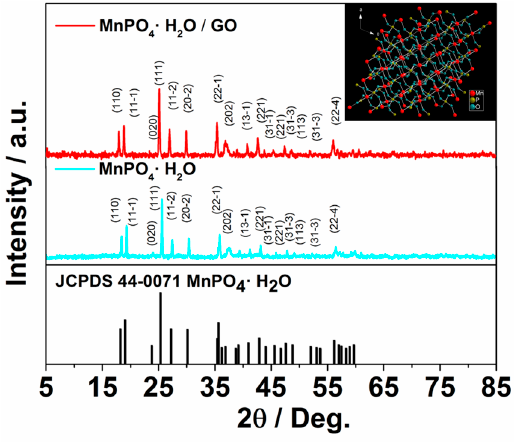
Figure 1. XRD (X ‐ Ray Diffraction) patterns of as ‐ prepared MnPO 4 ∙ H 2 O nanowire/GO (graphene oxide) composite material, as ‐ prepared MnPO 4 ∙ H 2 O sample without GO, and standard MnPO 4 ∙ H 2 O (JCPDS ‐ 44 ‐ 0071). Inset: the possible schematic crystal structures of MnPO 4 ∙ H 2 O.